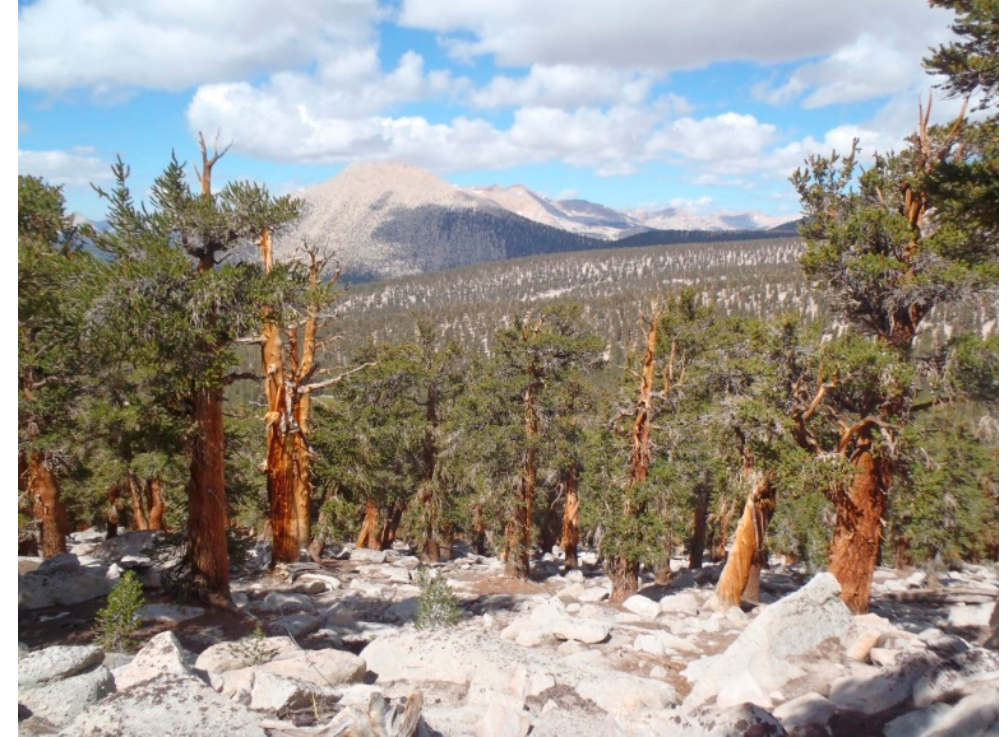
Figure 3. Foxtail pine near Rock Creek ranger station, Sequoia National Park, CA, USA. Photo taken by Jenny Cribbs (NPS), 2017.